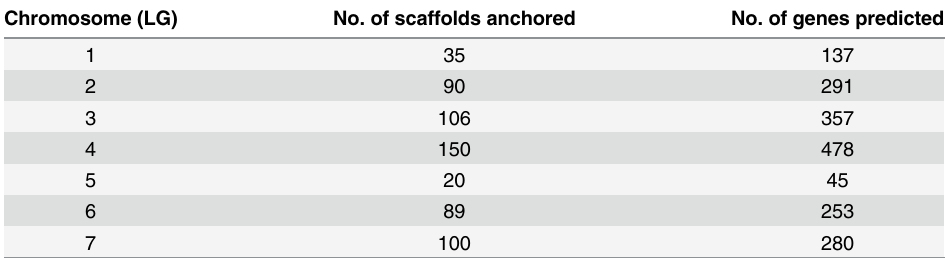
The candidate gene based map alone allowed anchoring 470 genome scaffolds, 40.63 Mb and approximately 3.6% of the genome, with 19 of these scaffolds locating two